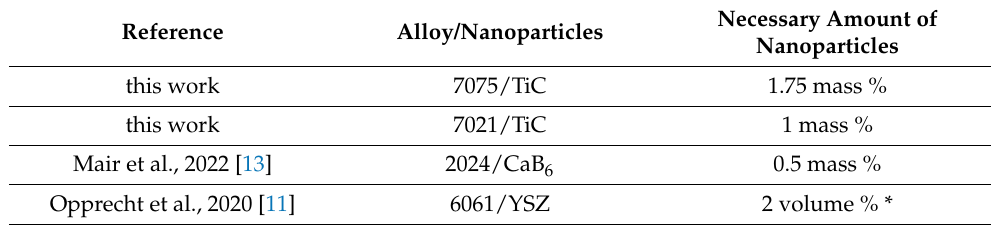
Table 4. The necessary content of nanoparticles for successful PBF-LB/M to suppress hot cracks.